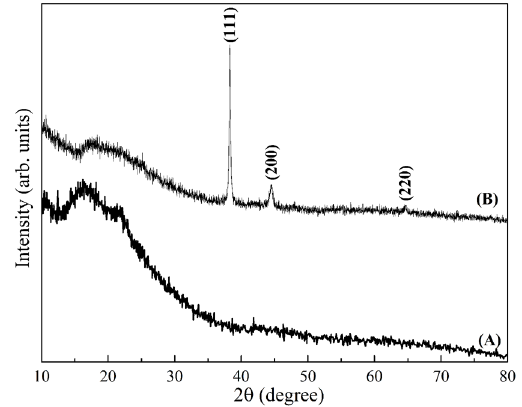
Figure 1. X-ray diffractograms of the opaque surface of the prepared (A) CA-M and (B) CA-Ag-M.